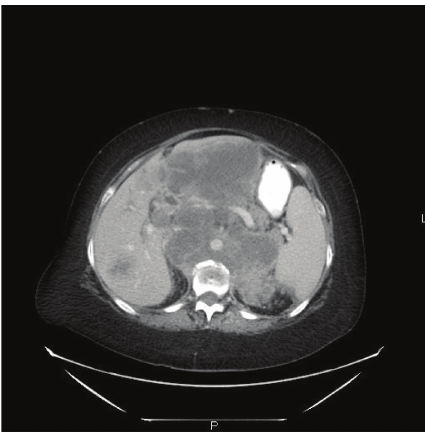
Figure 1: Computed tomography of abdomen showing a big retroperitoneal mass engulfing the vascular structures in the